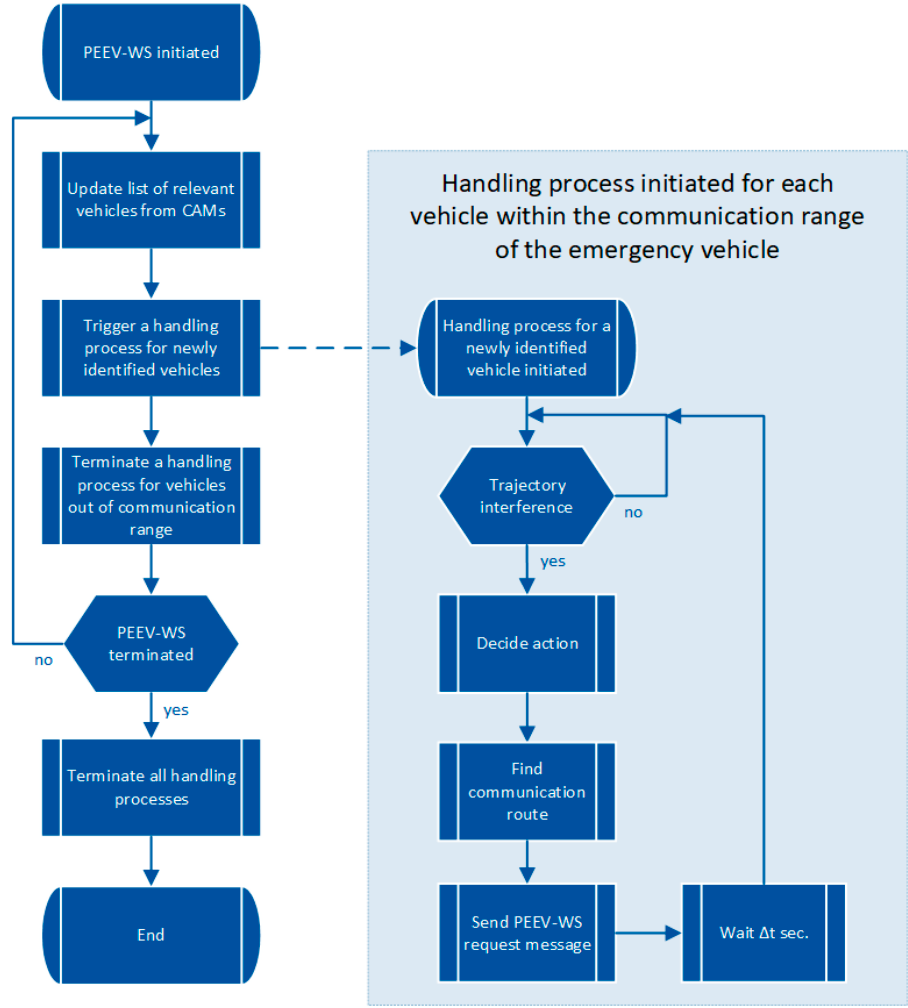
Figure 3. Flow chart of the main algorithm implemented by the PEEV-WS.